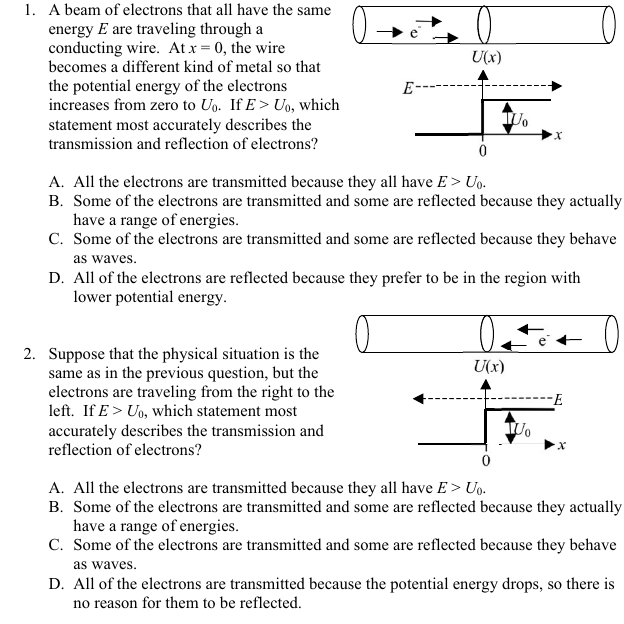
FIG. 9. Two questions designed to elicit the belief that reflection and transmission are due to a range of energies, adapted from Ref. (cid:3) 30 (cid:4) . The correct answer to both questions is